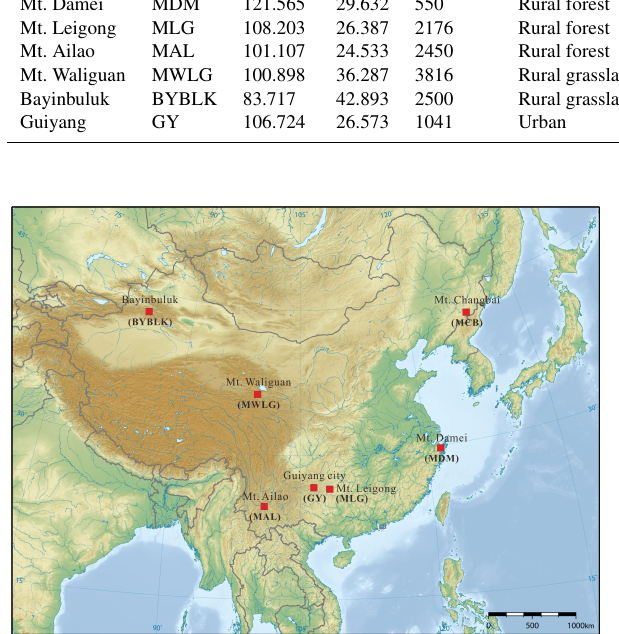
Figure 1. Locations of the sampling sites in this study.